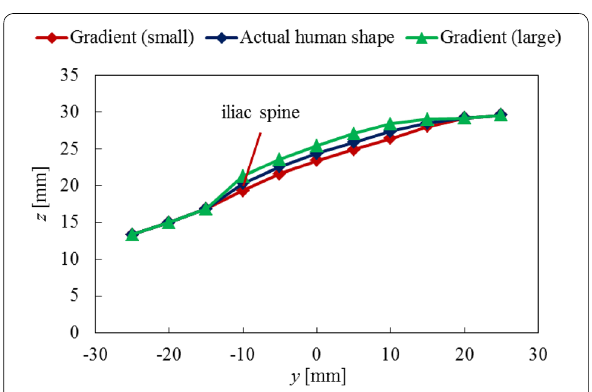
Fig. 12 Target shapes for the